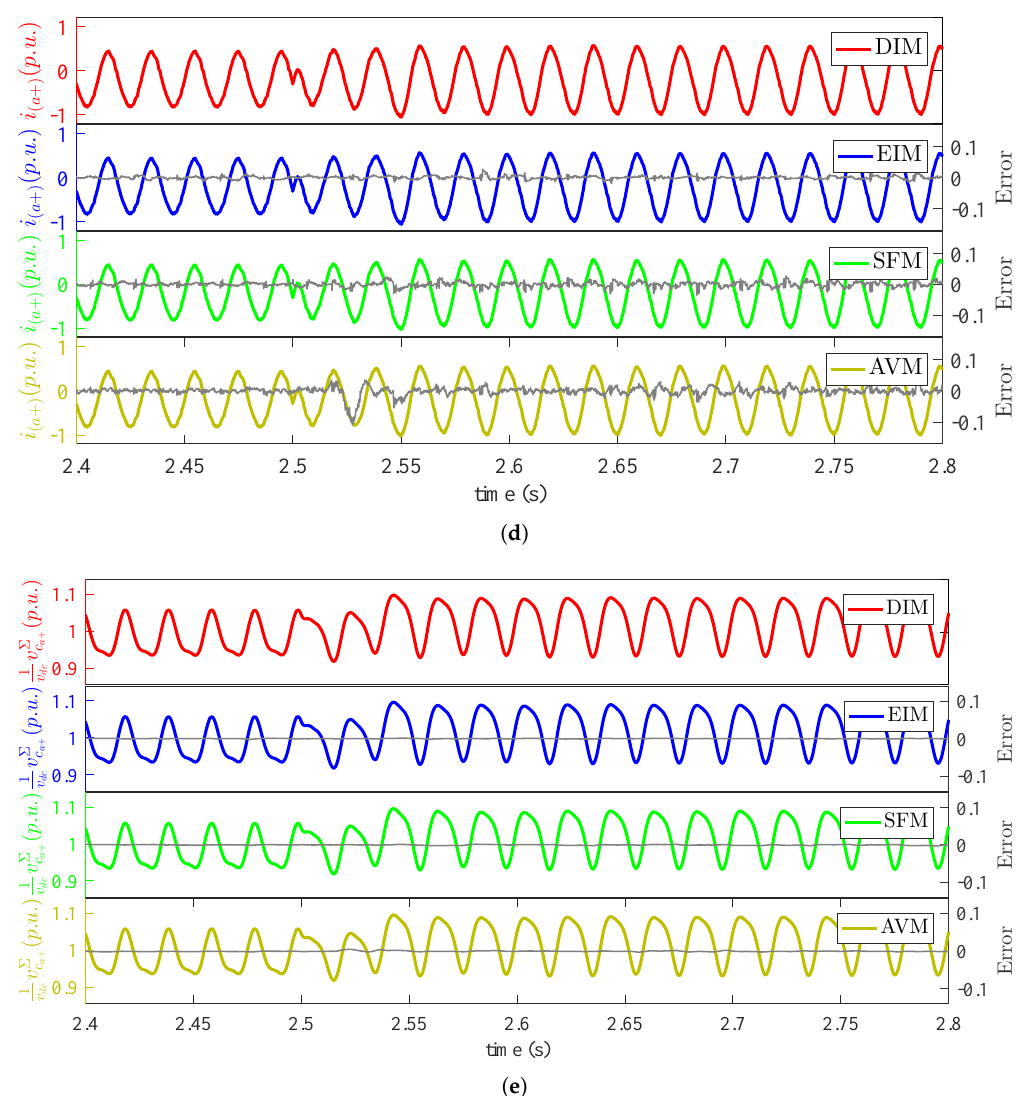
Figure 9. Reactive power reversal. ( a ) Real powerinjectedinthe AC-grid P andthemodelerror; ( b ) reactive powerinjectedin theAC-grid Q andthemodel error; ( c ) DC current i dc andthemodel error; ( d ) positive arm current i ( a +) andthemodelerror; ( e ) cumulativecapacitorvoltage v